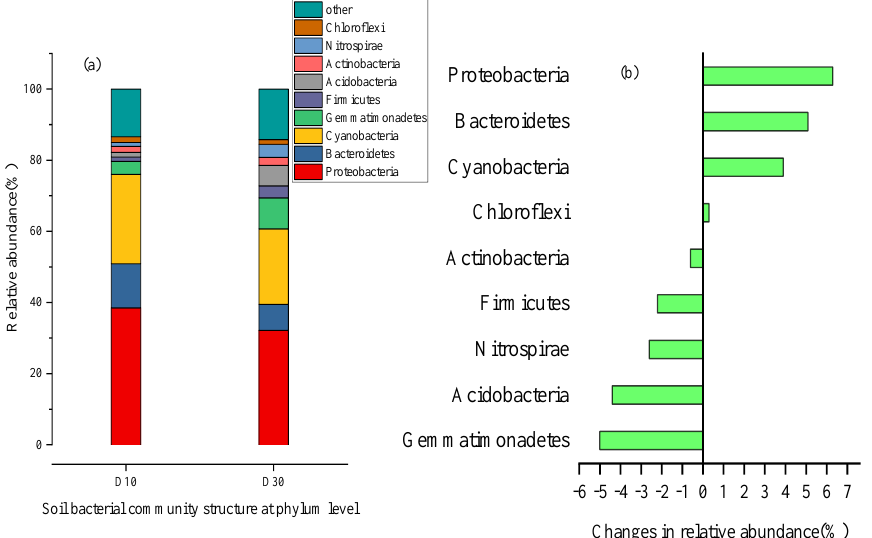
Figure 5. Soil microorganism changes in the wetland sediments at the phylum level. ( a ) Soil bacterial community structure at phylum level; ( b ) changes in relative abundance.